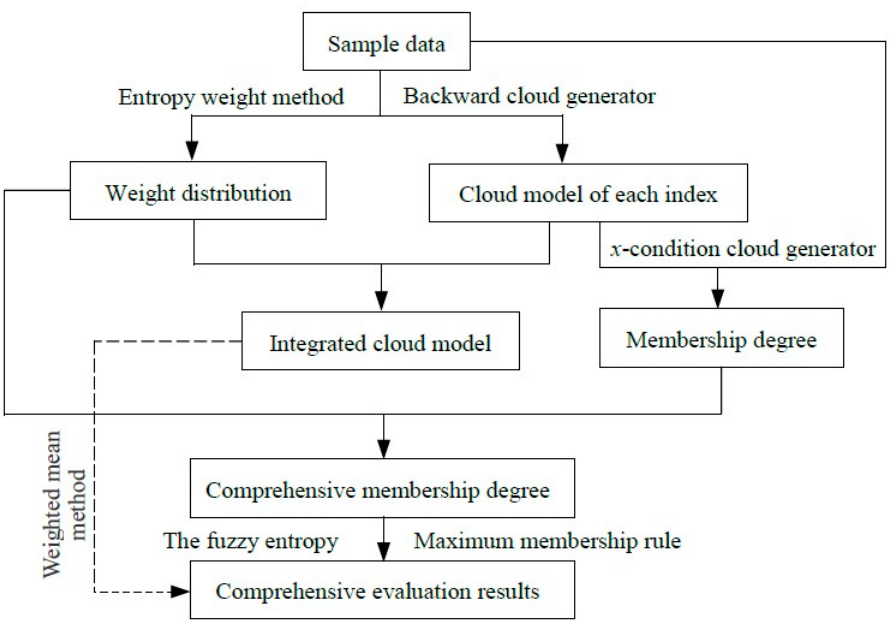
Figure 2. Calculation process by using the cloud model.